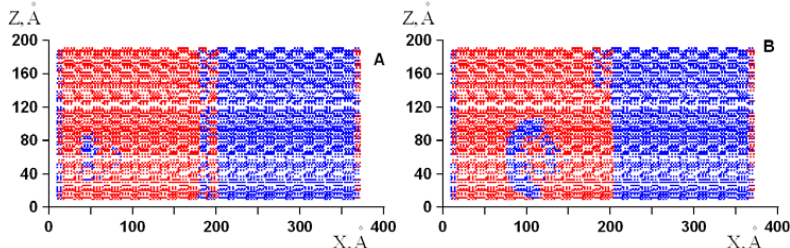
Fig. 5. A - normal impact of the cluster onto the surface. B - cluster impact angle α = 45 ◦